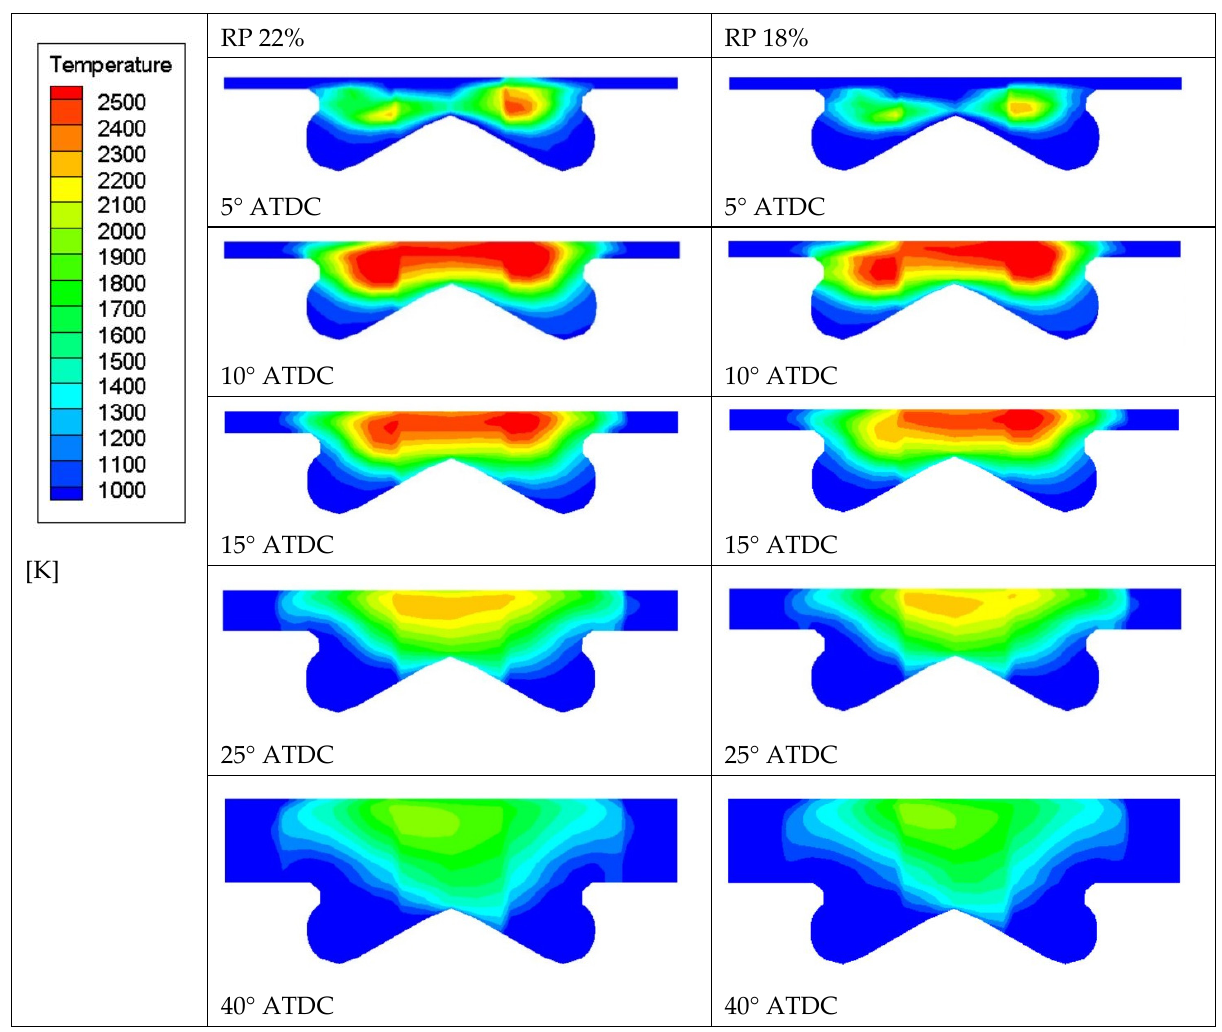
Figure 14. Temperature distributions in RP = 22 and 18% at 2000 rpm.